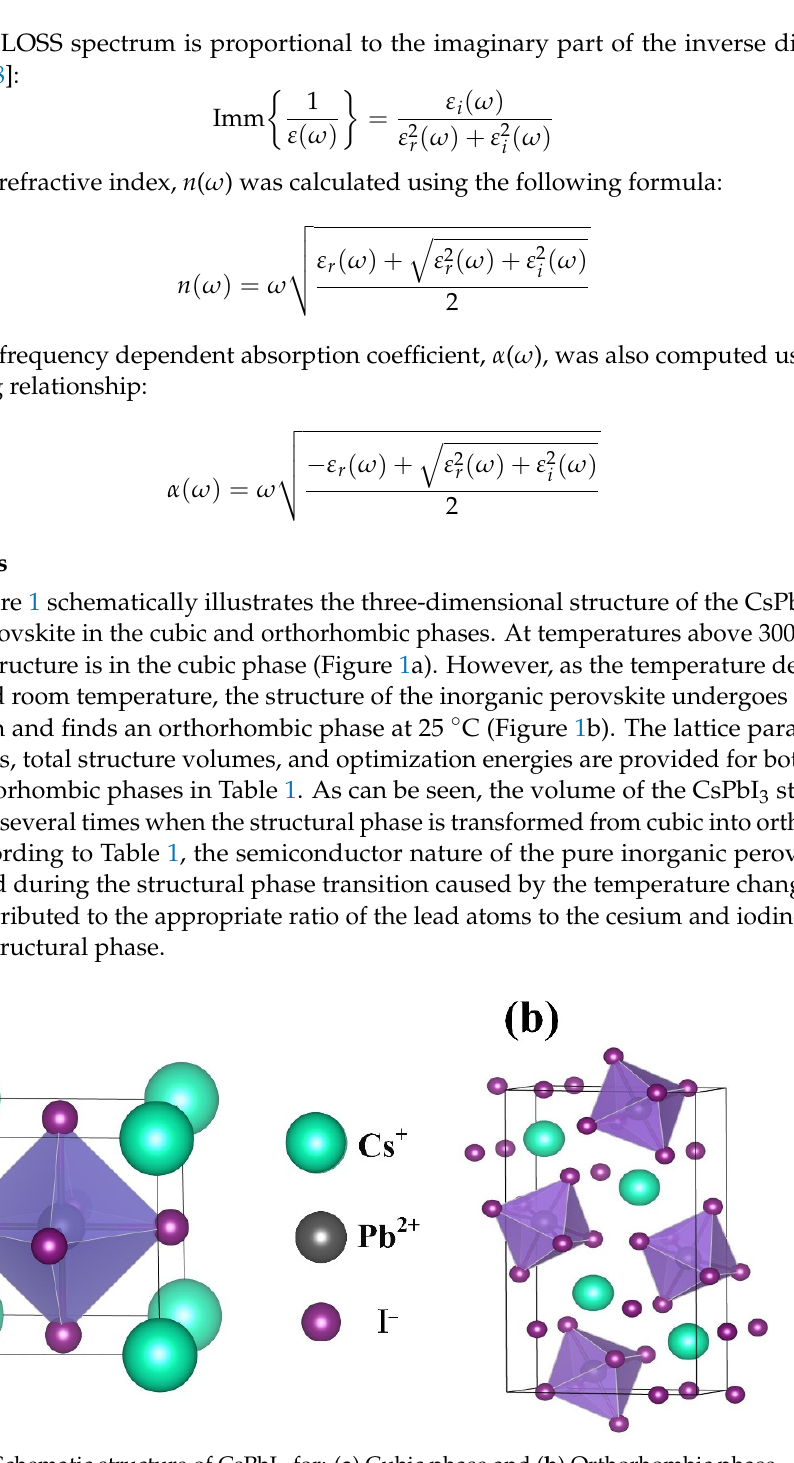
Figure 1. Schematic structure of CsPbI 3 for: ( a ) Cubic phase and ( b ) Orthorhombic phase.